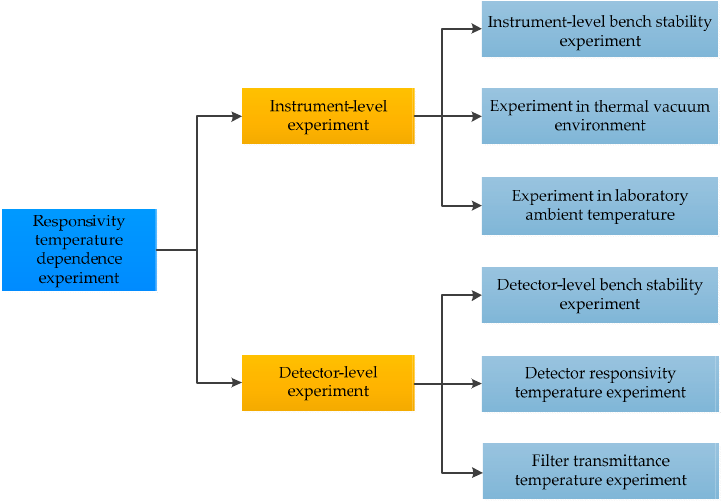
Figure 5. Diagram of the RTDC experimental structure.